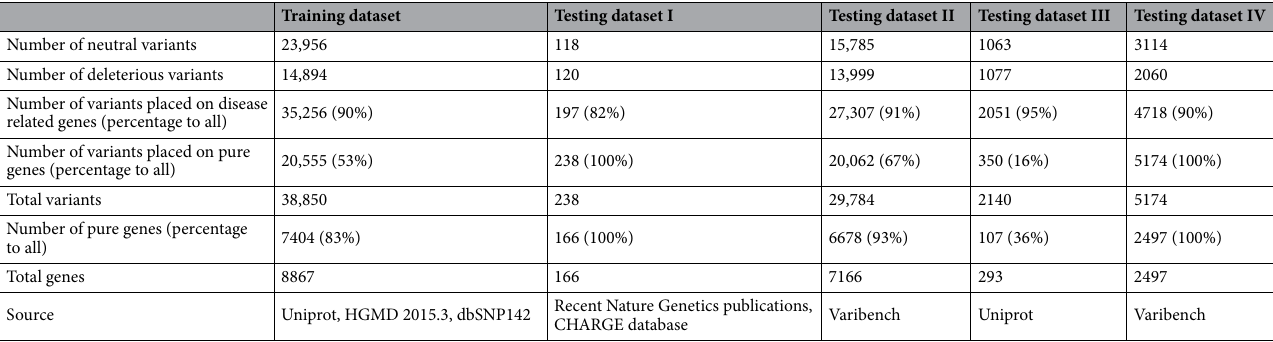
Table 1. Summary of training and testing data used in the current